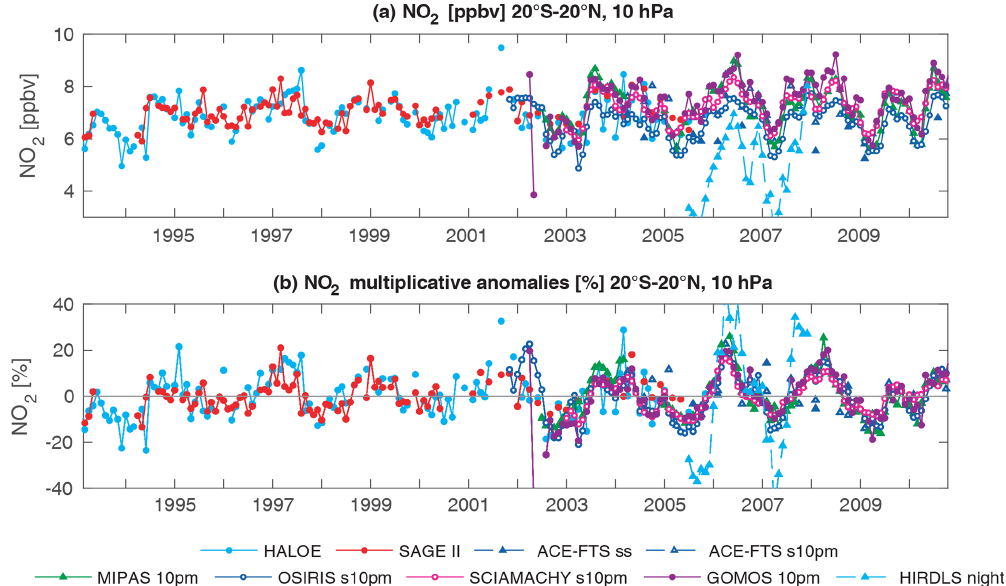
Figure 13. Time series of tropical NO 2 mean values (a) and deseasonalized anomalies (b) between 20 ◦ S–20 ◦ N at 10hPa for 1993–2010. Datasets correspond to local sunset or to 22:00LST as described in the text. The s10pm denotes zonal monthly mean fields scaled to 22:00LT, the ss zonal monthly mean fields from sunset